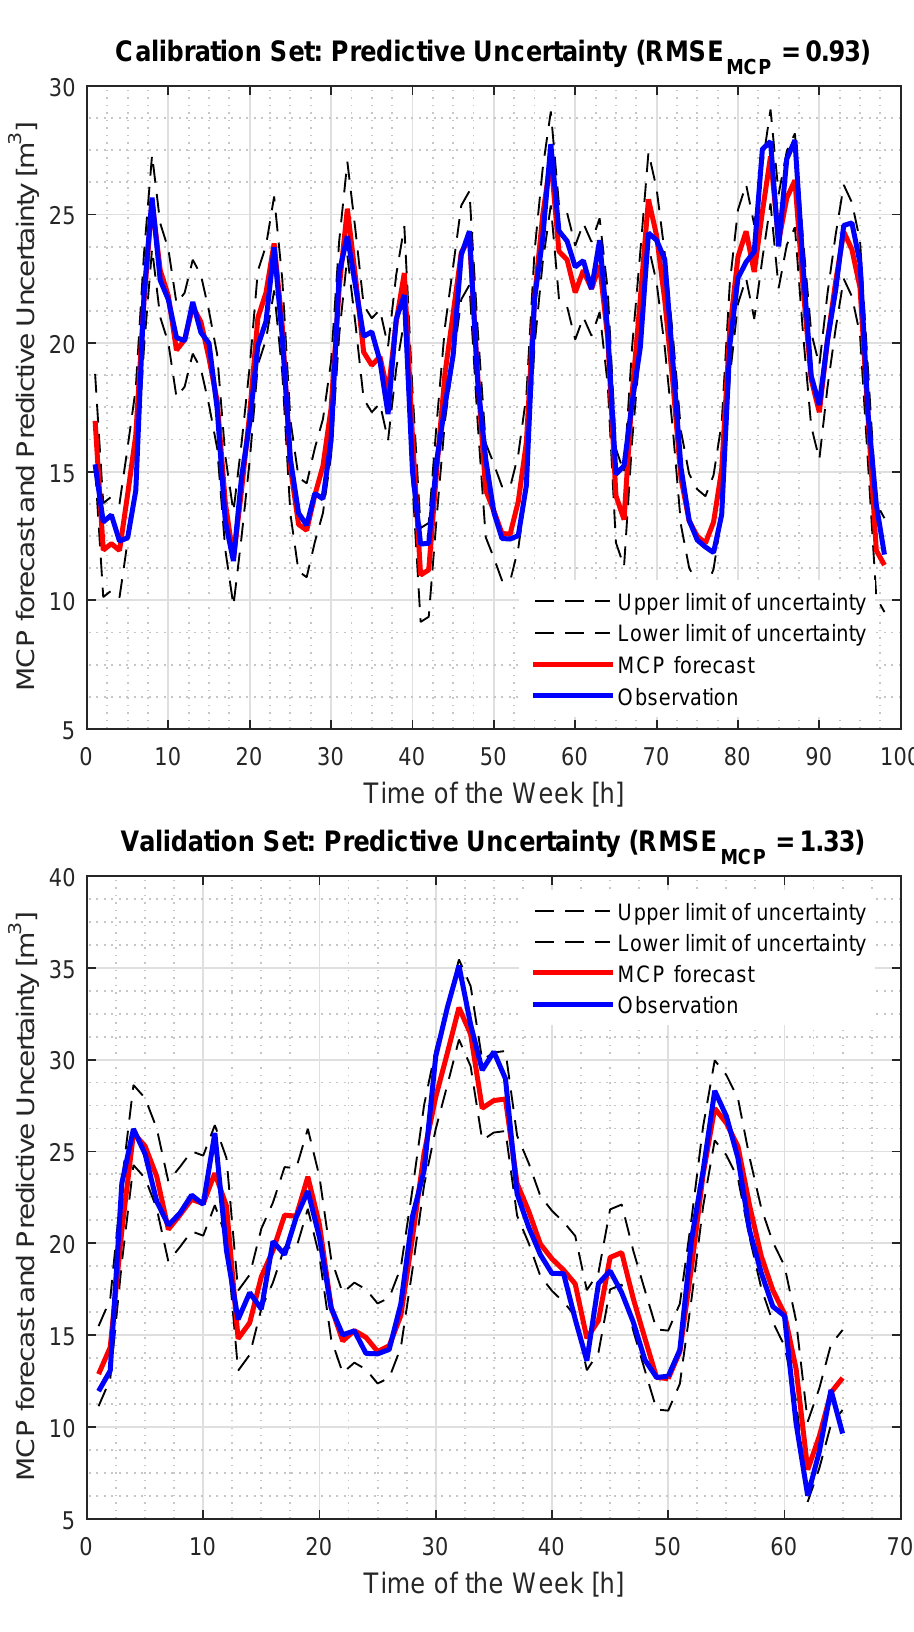
Figure 4. Calibration and Validation sets: MCP forecasts with estimated predictive